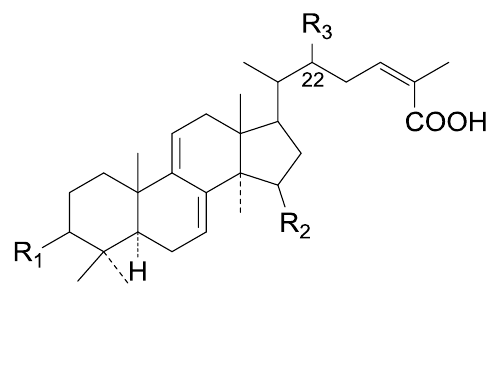
Figure 21. Structures of compounds 214 – 219